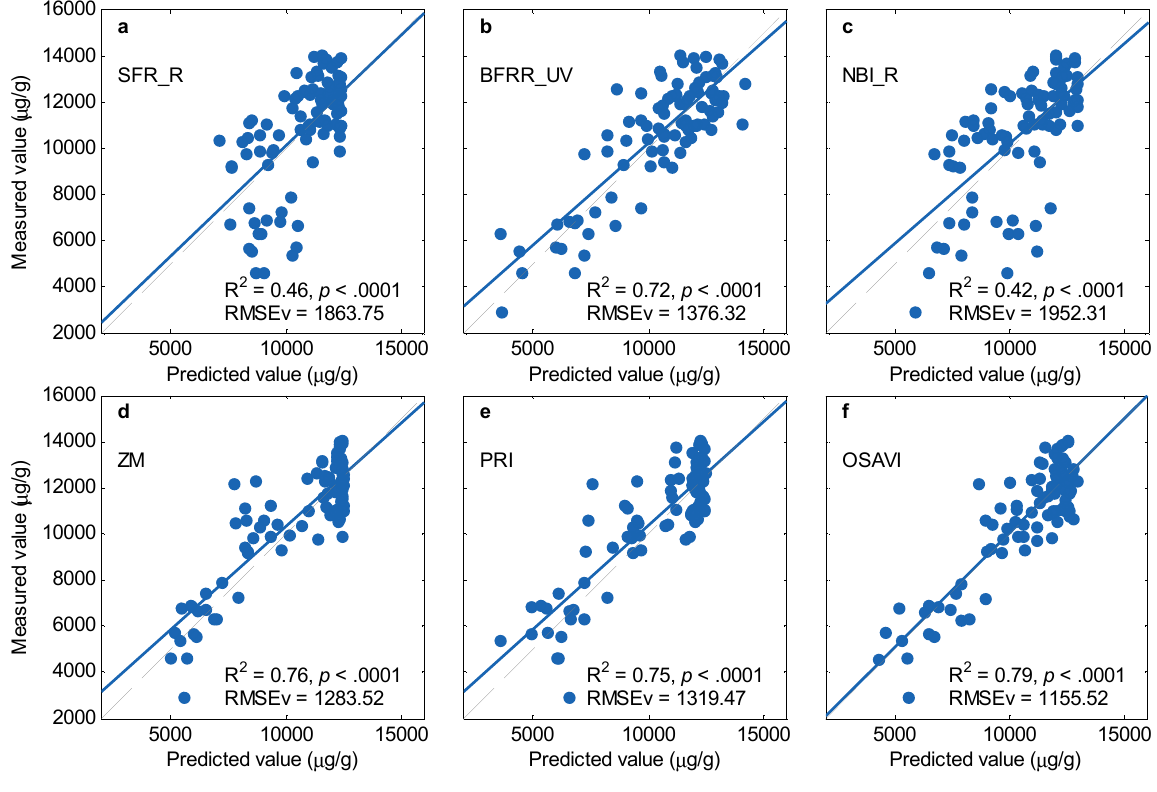
Figure 7. Measured-by-predicted values of LCC showing the validation results of ( a ) SFR_R, ( b ) BFRR_UV, ( c ) NBI_R, ( d ) ZM, ( e ) PRI and ( f ) OSAVI in predicting the LCC of the validation data set. Solid and dashed lines show the best linear fit and 1:1 lines,